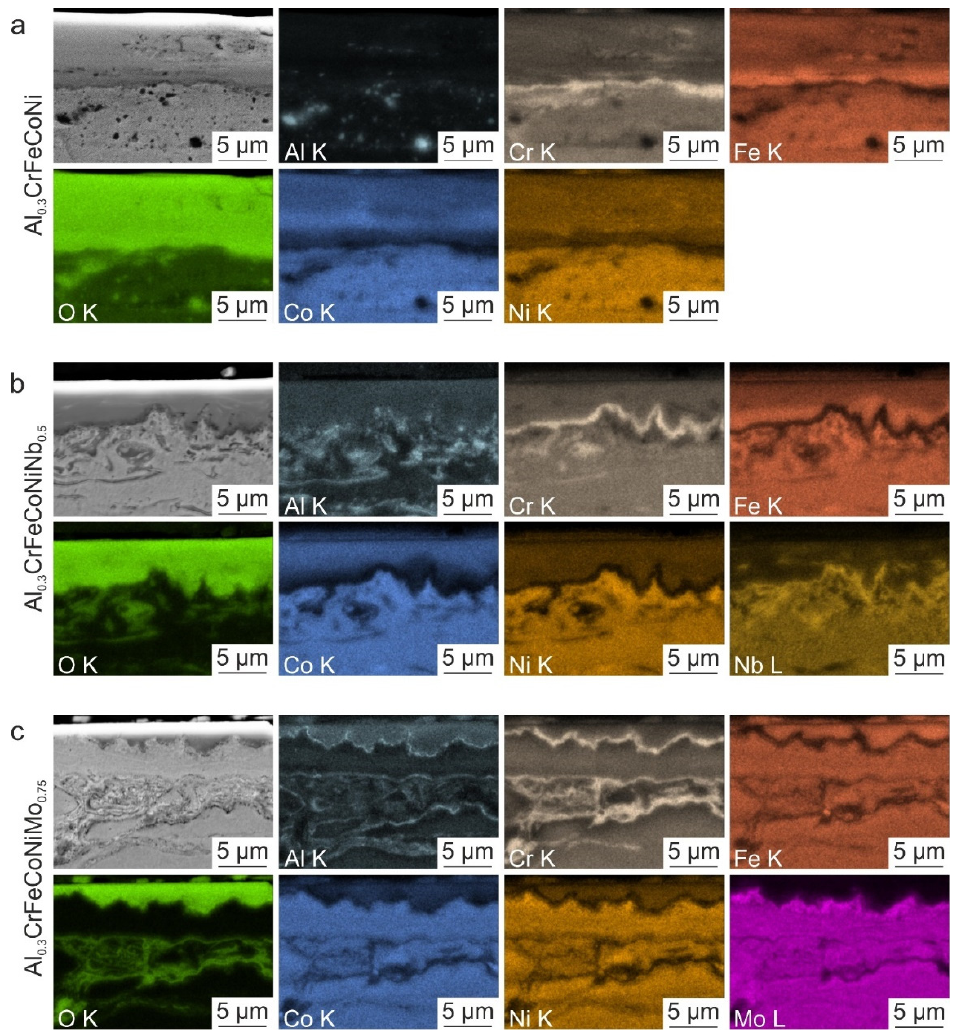
Figure 11. EDS maps of the oxide layer in the wear tracks after high-temperature wear tests at 900 °C of the HVOF-sprayed ( a ) Al 0.3 CrFeCoNi, ( b ) Al 0.3 CrFeCoNiNb 0.5 and ( c ) Al 0.3 CrFeCoNiMo 0.75 coatings. All oxide layers consist of a mixture of the alloying elements and O. In addition, a Cr-rich intermediate oxide layer was found for all HVOF-sprayed coatings. Furthermore, the elements Nb and Mo are preferably located in the HVOF-sprayed coatings at the convoluted interface with the oxide layer. Finally, a thin Al-rich oxide layer was determined between the HVOF-sprayed Al 0.3 CrFeCoNiMo 0.75 coating and the Cr-rich oxide layer.